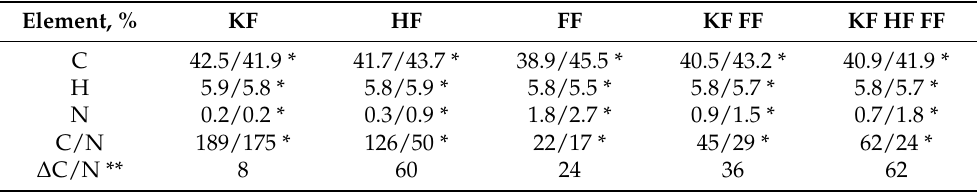
Table 4. Results of elemental analysis of materials before and after composting test. KF—-kraft fibers, HF—-hemp fibers, and FF—-fungus